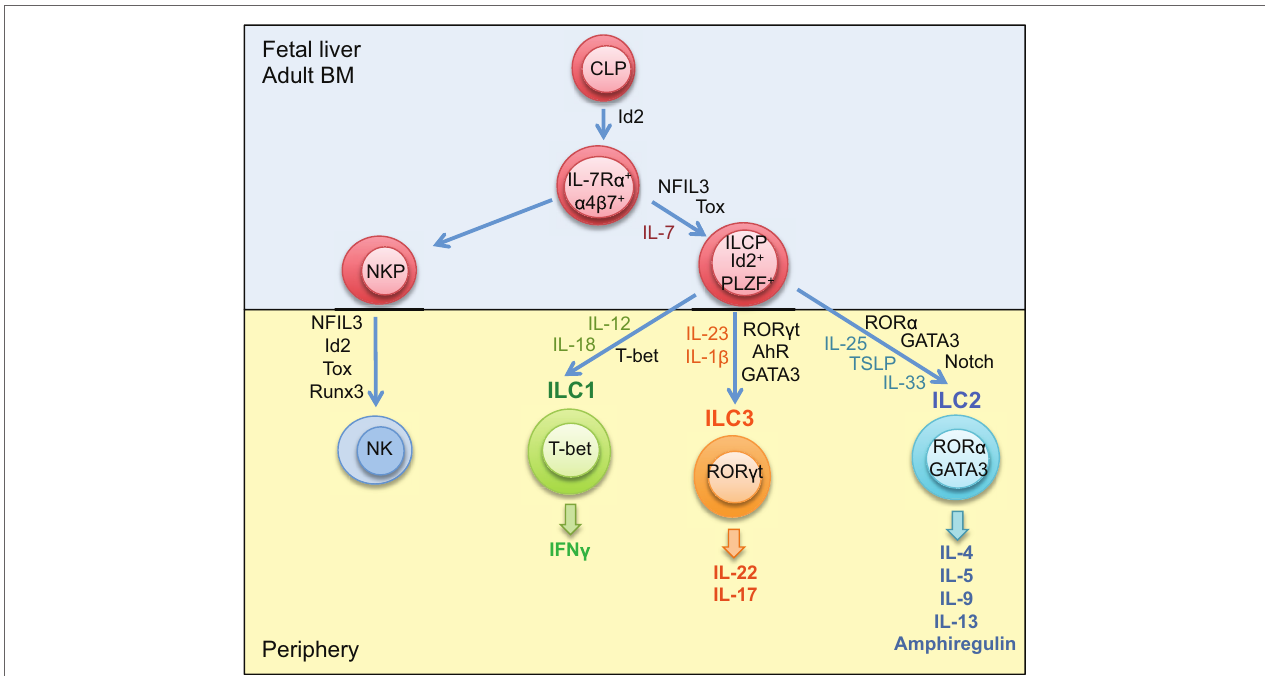
FiGURe 1 | Development of innate lymphoid cells . Innate lymphoid cells differentiate from common lymphoid progenitors in the fetal liver or adult bone marrow. The ILC precursor develops from CLP under the influence of the transcription factors Id2, PLZF, NFIL2, and Tox. ILC1, ILC2, and ILC3 differentiate from ILCP dependent on T-bet, ROR α , and GATA3, and ROR γ t, respectively. Maturation and activation of ILC1 requires IL-12 and IL-18; ILC2 requires IL-25, IL-33, and TSLP and the influence of the Notch signaling pathway; ILC3 requires IL-23 and IL-1 β and the additional influence of the transcription factor AhR. NK cells develop from NK precursors in the bone marrow under the influence of the transcription factors Id2, NFIL3, Tox, and Runx3. CLP, common lymphoid progenitor; ILCP, innate lymphoid cell progenitor; NKP, natural killer cell progenitor; Id2, inhibitor of DNA binding 2; PLZF, promyelocytic leukemia zinc finger protein; ROR α , RAR-related orphan receptor α ; AhR, aryl hydrocarbon